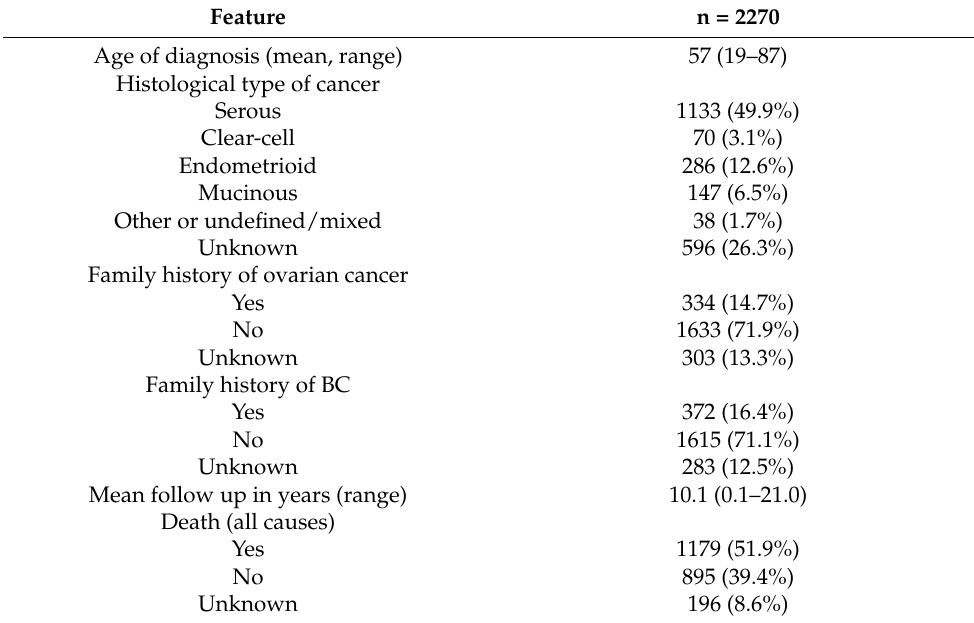
Table 4. Characteristics of ovarian cancer